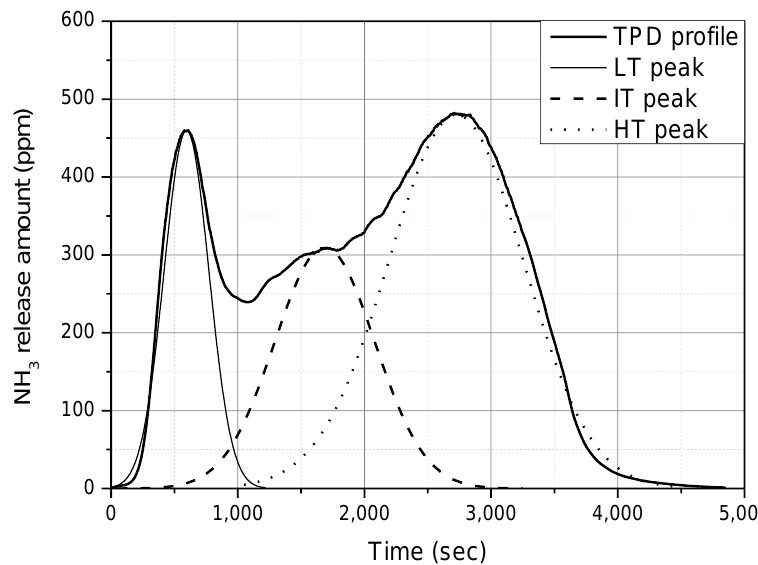
Figure 5. An example of curve fitting of TPD curve with three normal distribution curves of the LT, IT, and HT peak (inlet NH 3 concentration: 200 ppm, NH 3 supply time: 7500 s, temperature of NH 3 absorbing: 50 °C).